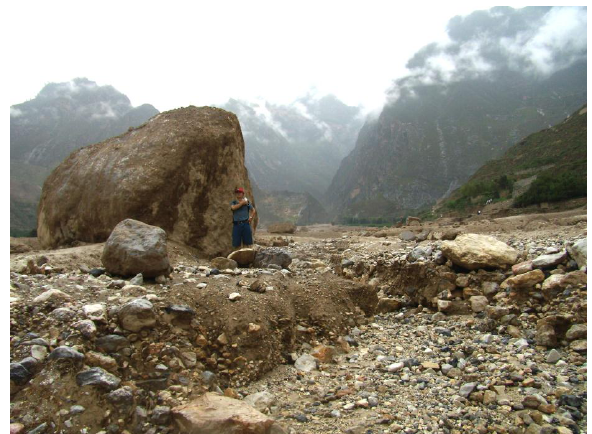
Fig. 16. Photography showing the largest boulder (which exceeded a diameter of 6m) deposited in the depositional zone when the flow spread out over agricultural terraces.